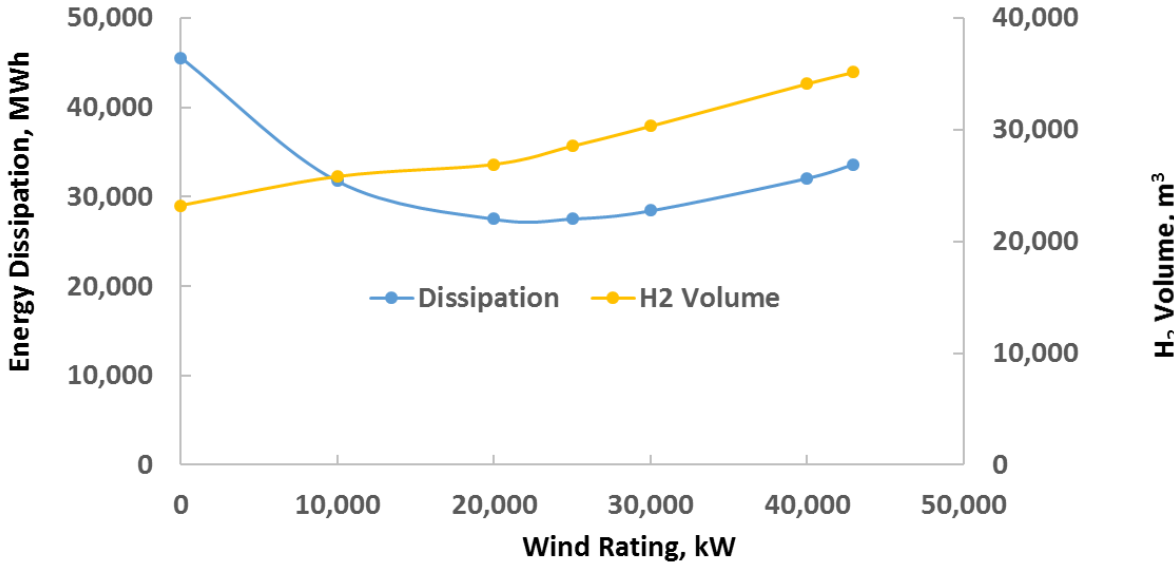
Figure 4. Annual energy dissipation and volume of hydrogen storage needed for the storage– regeneration process.